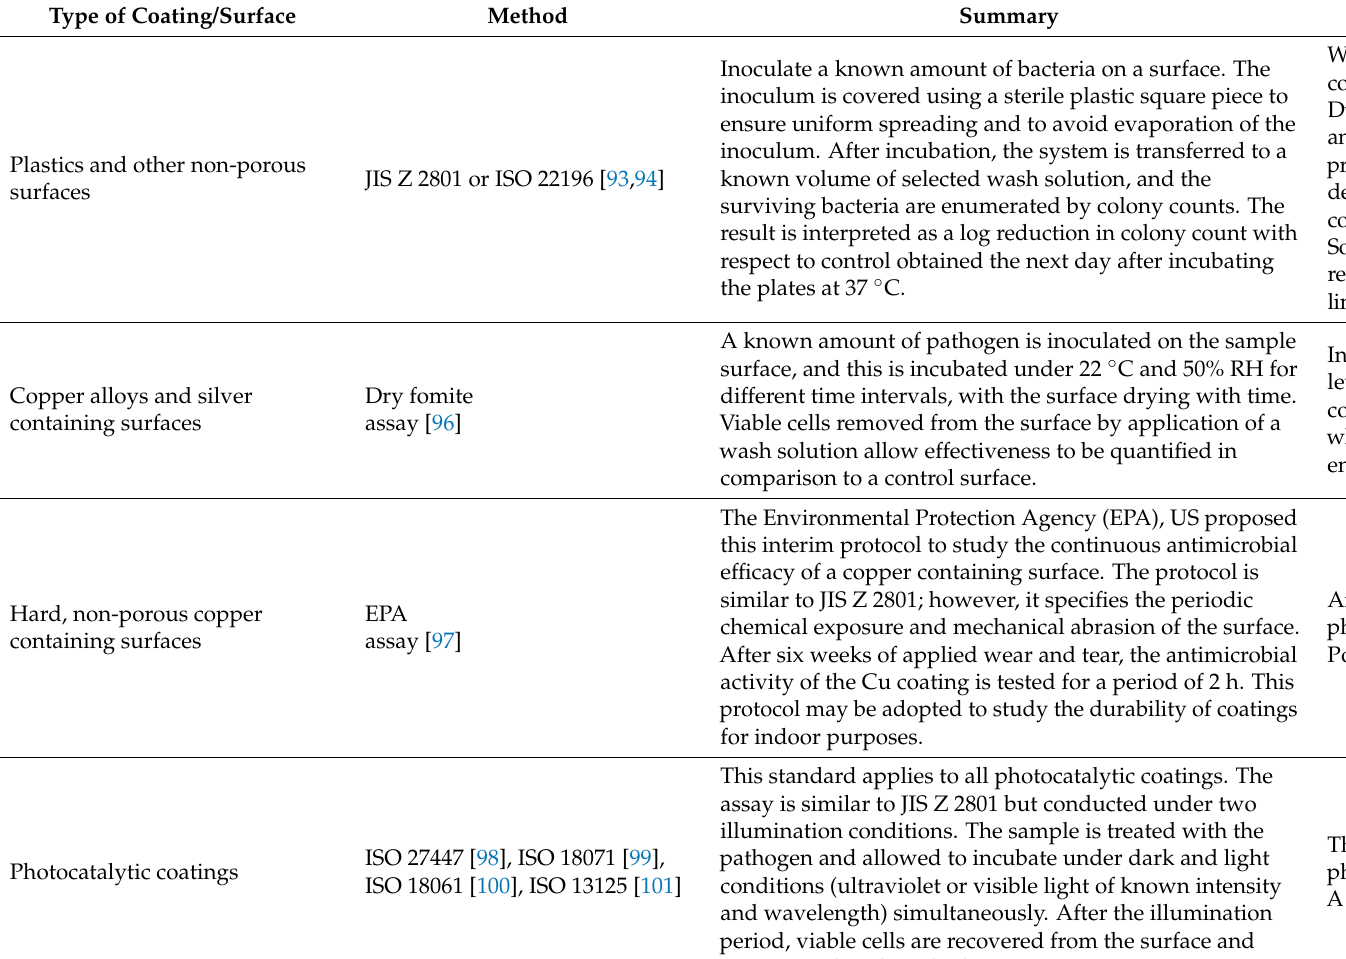
Table 1. Methods for studying the activity of